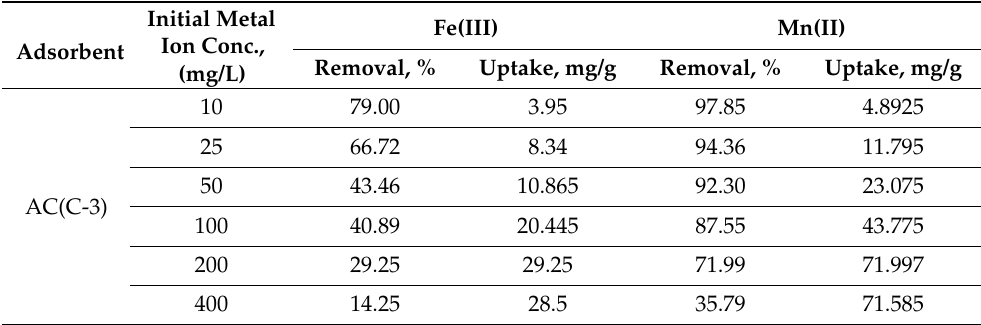
Table 8. The influence of initial concentration of metal ions on the absorption and removal by AC (C- 3) of Fe(III) and Mn(II) from aqueous solutions (conc. = 50 mg/L, time = 1 h, wt. = 0.05 gm, agitation velocity = 100 rpm and temp. 25 ◦ C) by